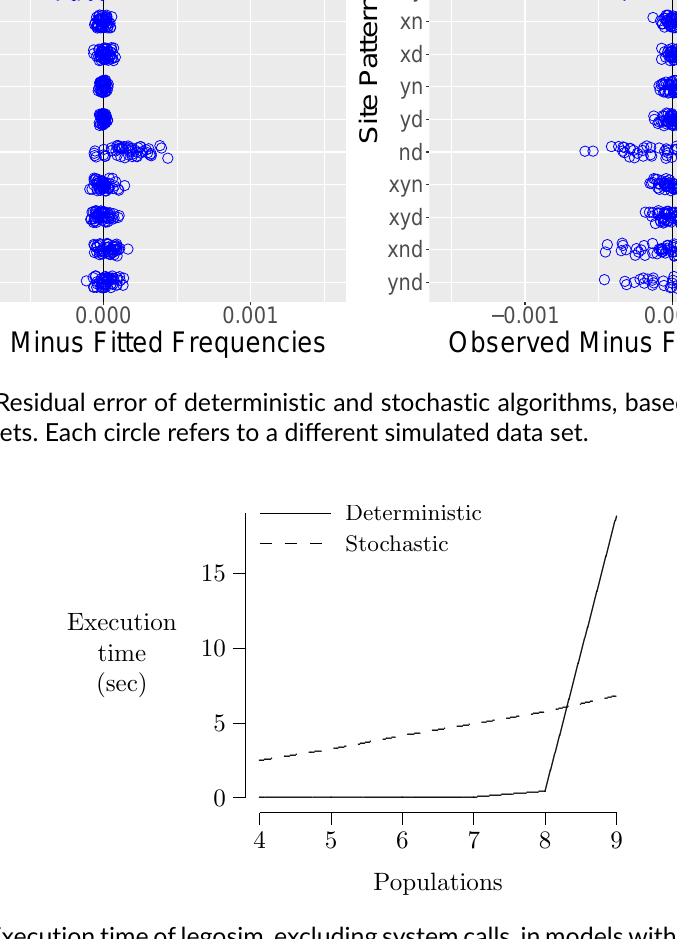
Figure 6 – Execution time of legosim, excluding system calls, in models without migration. For the stochastic algorithm, each run used two million